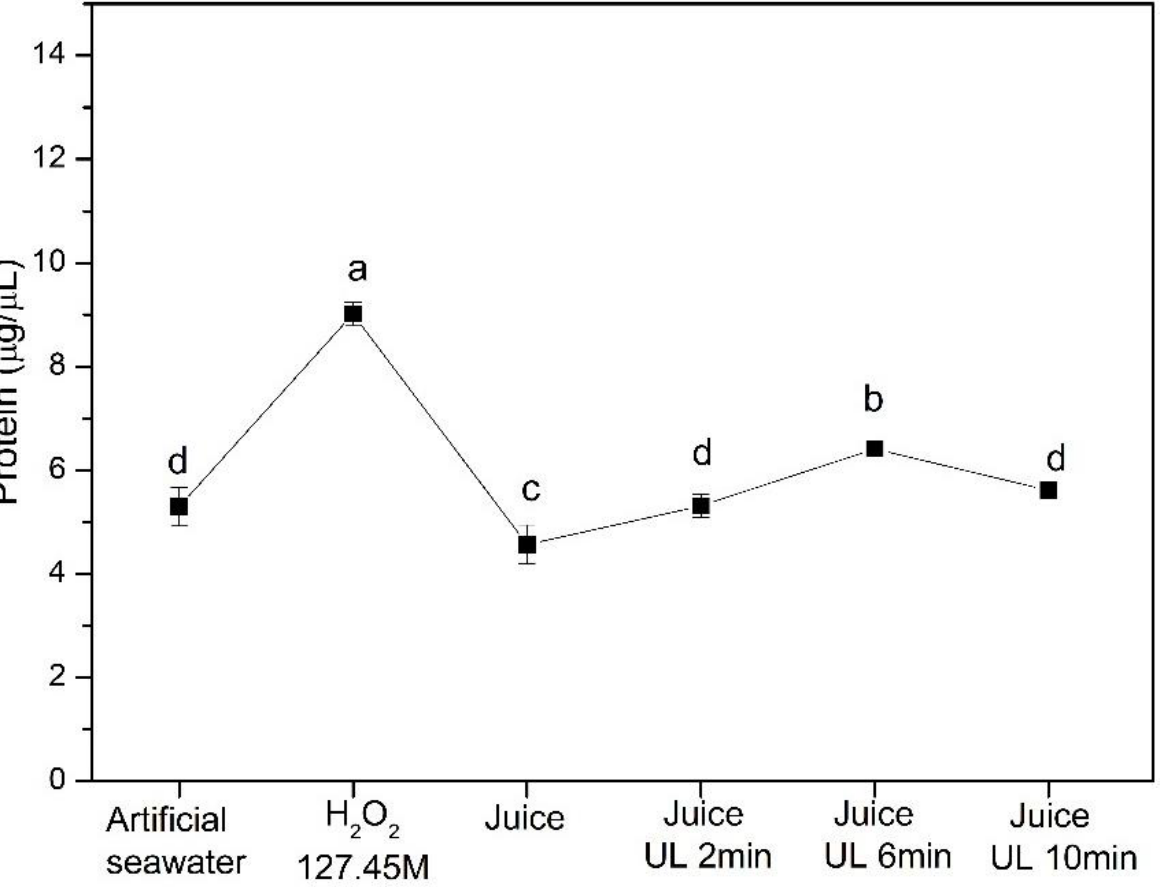
Figure 8. The protein content of unprocessed sapota-do-Solimões juice and processed by ultrasound (1000 μg·mL −1 ) on Artemia salina nauplii after 72 h of H 2 O 2 exposure. The different letters indicate statistically significant differences ( p ≤ 0.05).